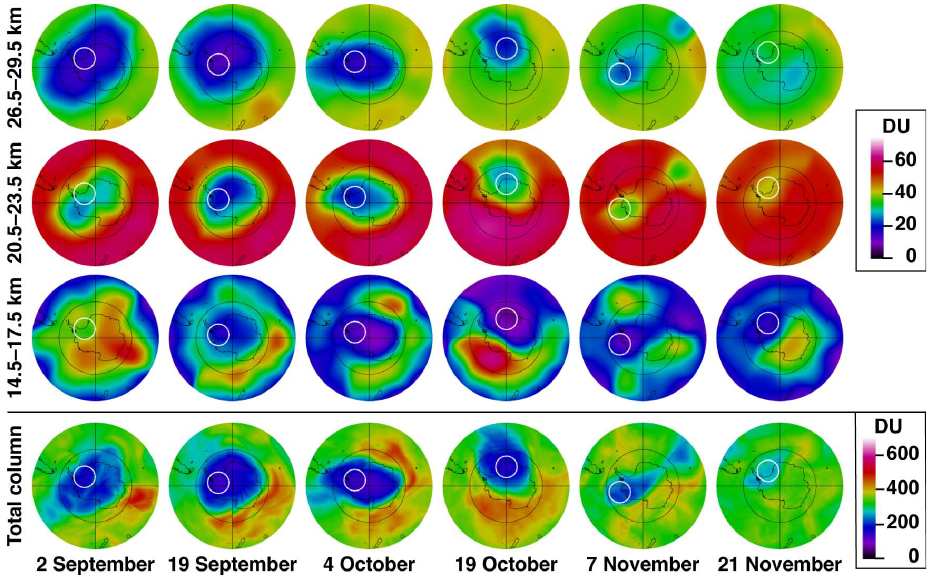
Fig. 7. OMPS LP column ozone amounts for 3 layers (26.5–29.5km, 20.5–23.5km, and 14.5–17.5km) and OMPS TC-NM total column ozone amounts for 2 September, 19 September, 4 October, 19 October, 7 November, and 21 November 2012. The white circles are within a radius of 1000km of the center of the vortex for that day (see Fig. 6 for how the center of the polar vortex is